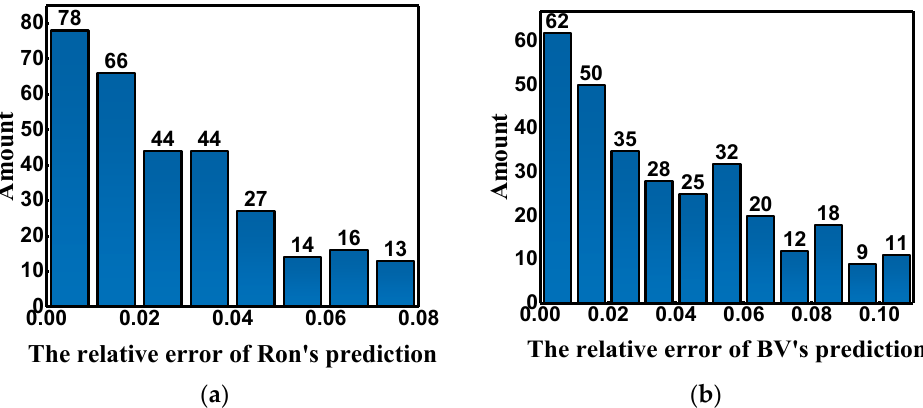
Figure 8. The error distribution histogram of the predicted results; ( a , b ) are the error distribution histograms of Ron and BV, respectively.